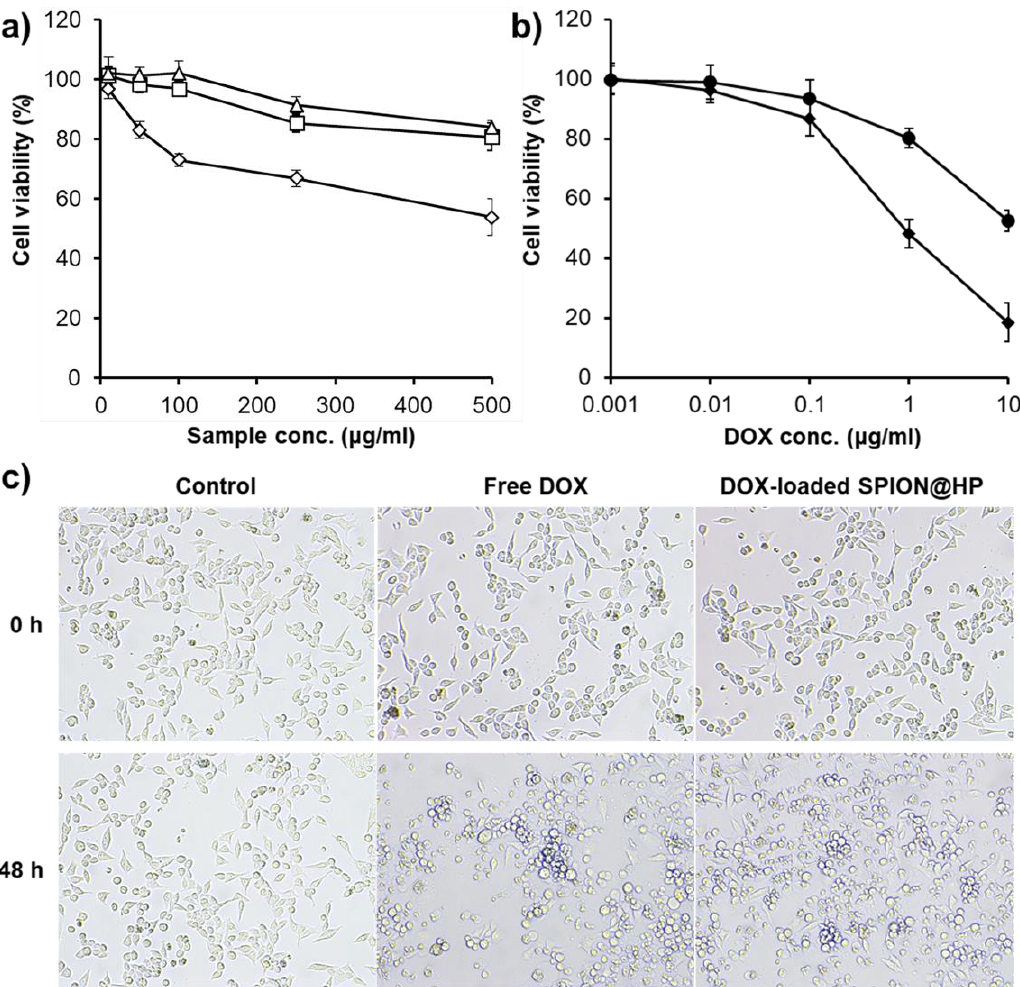
Figure 7. ( a ) Viability of HeLa cells when treated with HP ( △ ), SPIONs ( ), and SPION@HP ( ◻ ); ( b ) dose-dependent cytotoxicity of DOX-loaded SPION@HP ( ● ) and free DOX ( ◆ ) after 48 h of incubation; and ( c ) image of HeLa cells incubated with free DOX and DOX-loaded SPION@HP at 10 μg mL − 1 . Data are expressed as mean ± SD ( n = 3).